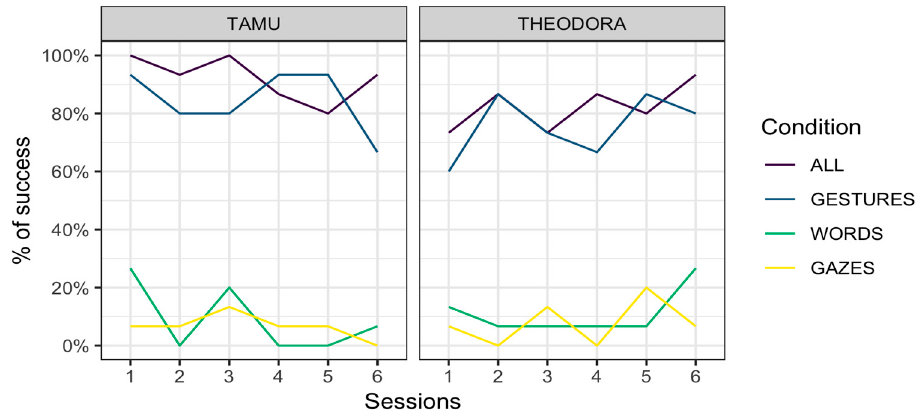
Figure 1. Performance for the two subjects across conditions and sessions.